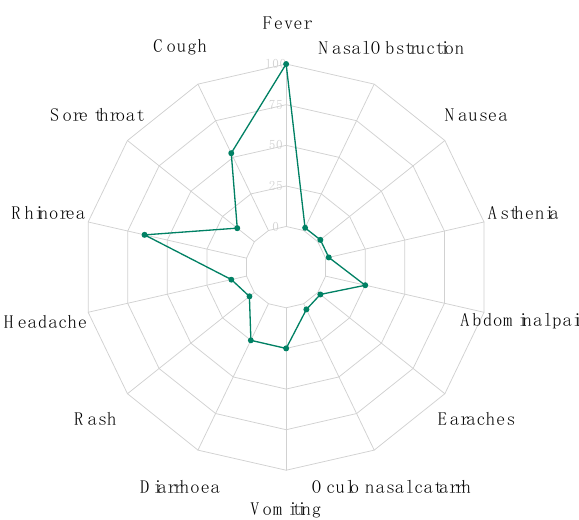
Figure 3. Plot showing the percentage of recorded symptoms among enrolled patients.